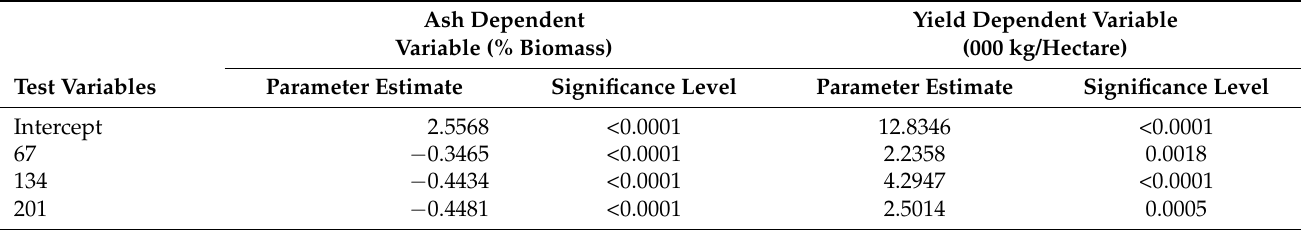
Table 3. Parameter estimates and significance for the ANOVA of ash content (% of biomass) of Alamo switchgrass and ANOVA of switchgrass yield when varying nitrogen fertilizer (N) application rates (kg/hectare).